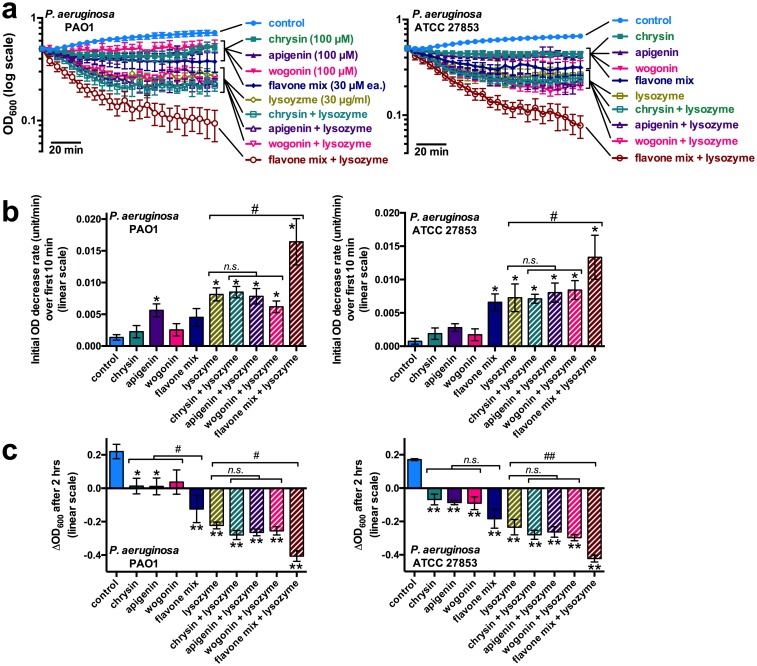
Synergistic anti-bacterial effects of flavones in combination with the airway antimicrobial protein lysozyme.(A) Traces of planktonic growth of P. aeruginosa in the presence of flavones ± lysozyme. Note the greatest OD600 decrease (bacterial lysis) occurred with lysozyme and flavone mix combined. (B) Bar graphs of the initial OD decrease rate (OD600 units/min) from A (n = 3–6 experiments for each condition). (C) Bar graphs showing ΔOD600 after 2 hours from A. For B and C, asterisks denote significance vs. control (LB only) by one-way ANOVA, Dunnett’s post-test (* = p <0.05, ** = p <0.01); # and ## indicates p <0.05 and 0.01, respectively, between bracketed bars (one-way ANOVA, Bonferonni post-test).